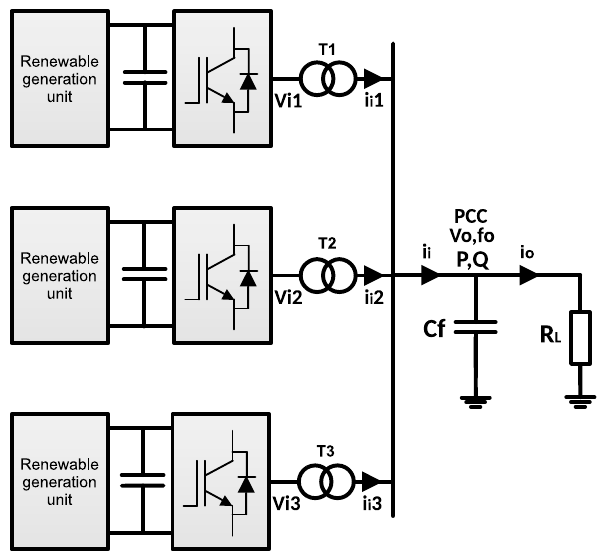
Figure 1. The proposed topology.